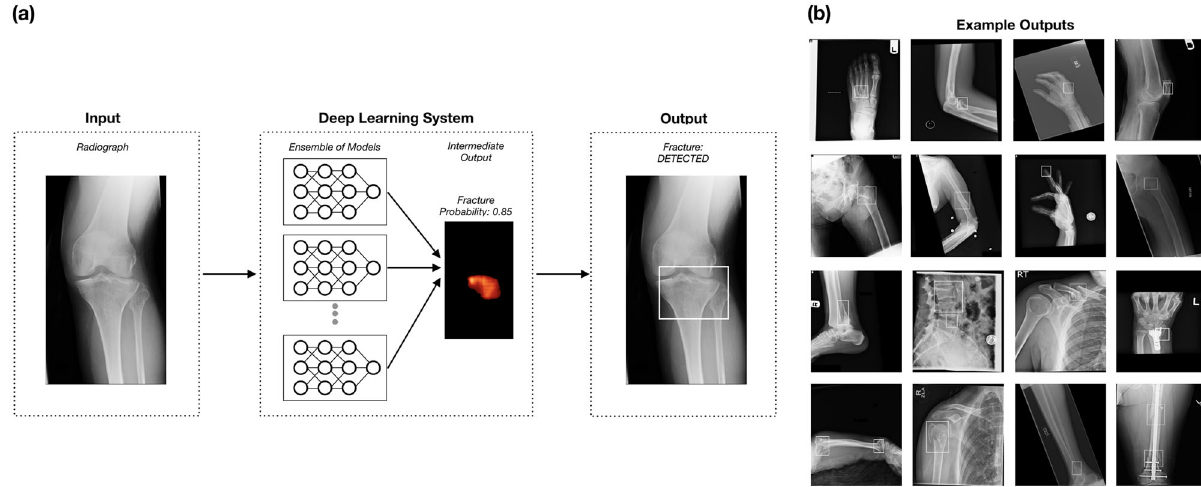
Fig. 1 The deep-learning system. a The deep-learning system used an ensemble of 10 convolutional neural networks. To produce a prediction, radiographs are processed by each network in the ensemble, averaged, and then post-processed to generate an overall fracture determination and bounding boxes. b Example outputs for each of the 16 anatomical regions supported by the deep-learning